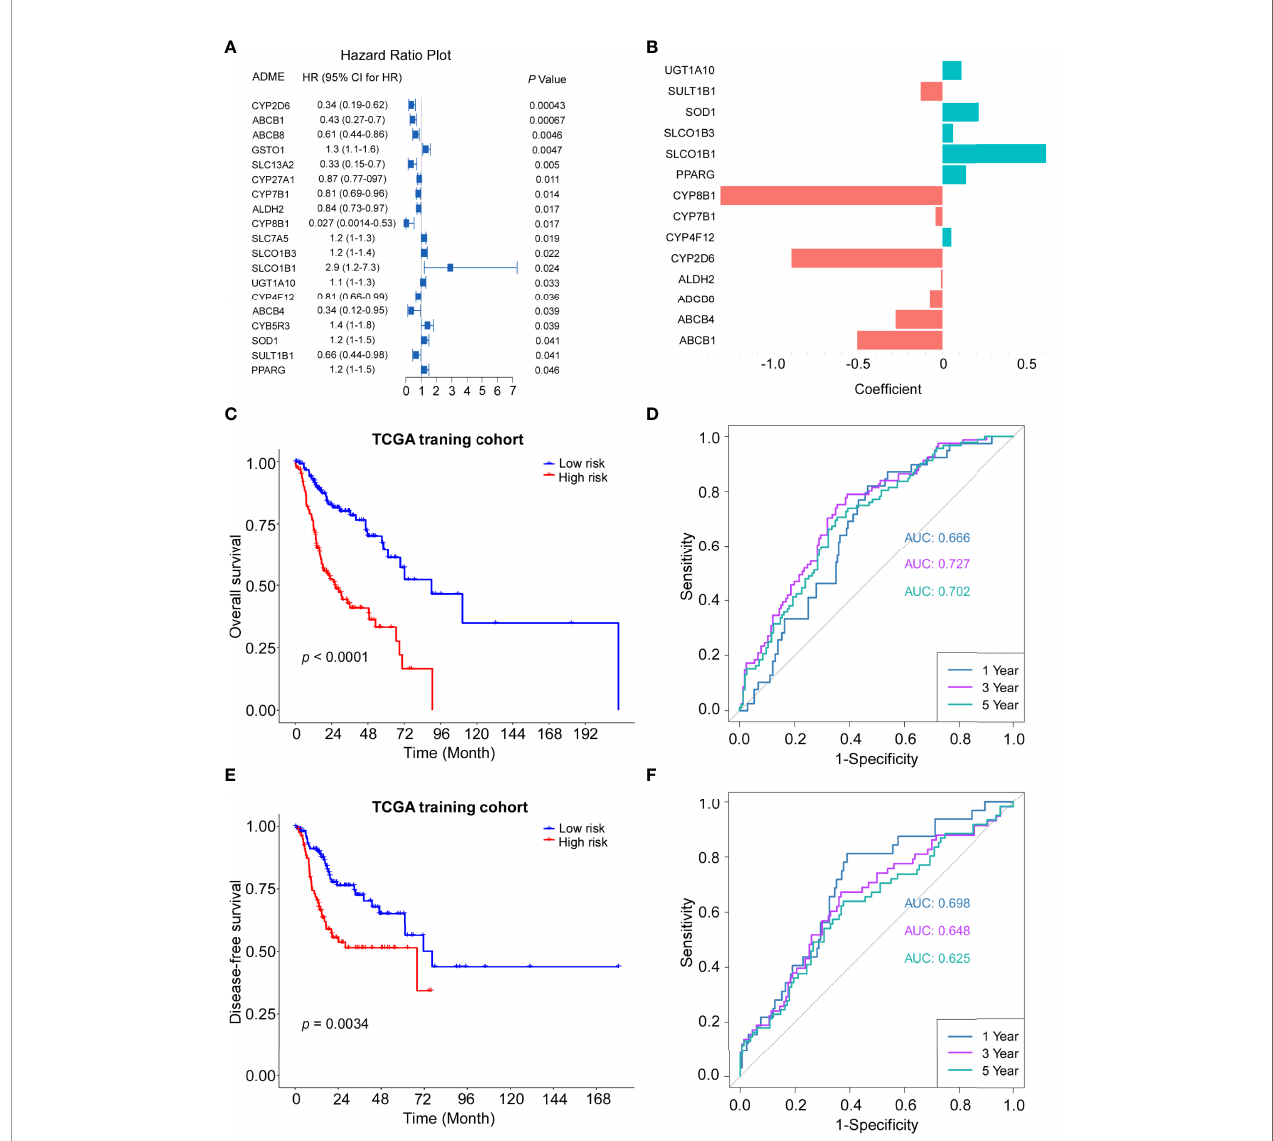
FIGURE 3 | Construction of the 14-gene signature in the TCGA train cohort. (A) Forest plot of the univariate Cox regression analysis between expression of 19 ADME genes and OS. (B) The coef fi cients of 14 ADME genes. (C) Kaplan – Meier curves for the OS of high-risk and low-risk groups in the training cohort. Log-rank test, P <0.0001. (D) Time-dependent ROC curve of risk score in train cohort on OS. (E) Kaplan – Meier curves for the disease-free survival (DFS) of high-risk and low- risk groups in the training cohort. Log-rank test, P=0.0034. (F) Time-dependent ROC curve of risk score in train cohort on